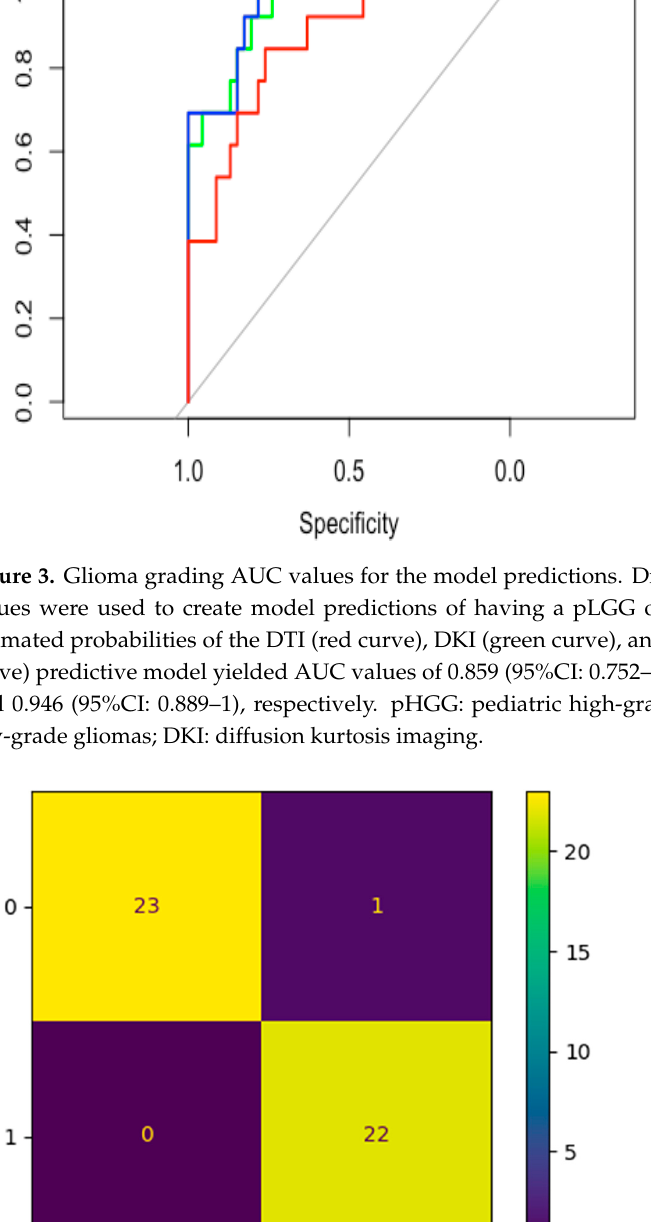
Figure 4. Confusion matrix of the random SMOTE analysis on the testing set of 46 patients (label 1 = pHGG, label 0 = pLGG). A model based on all DKI metrics correctly predicted all but one of the generated samples. DKI: diffusion kurtosis imaging.